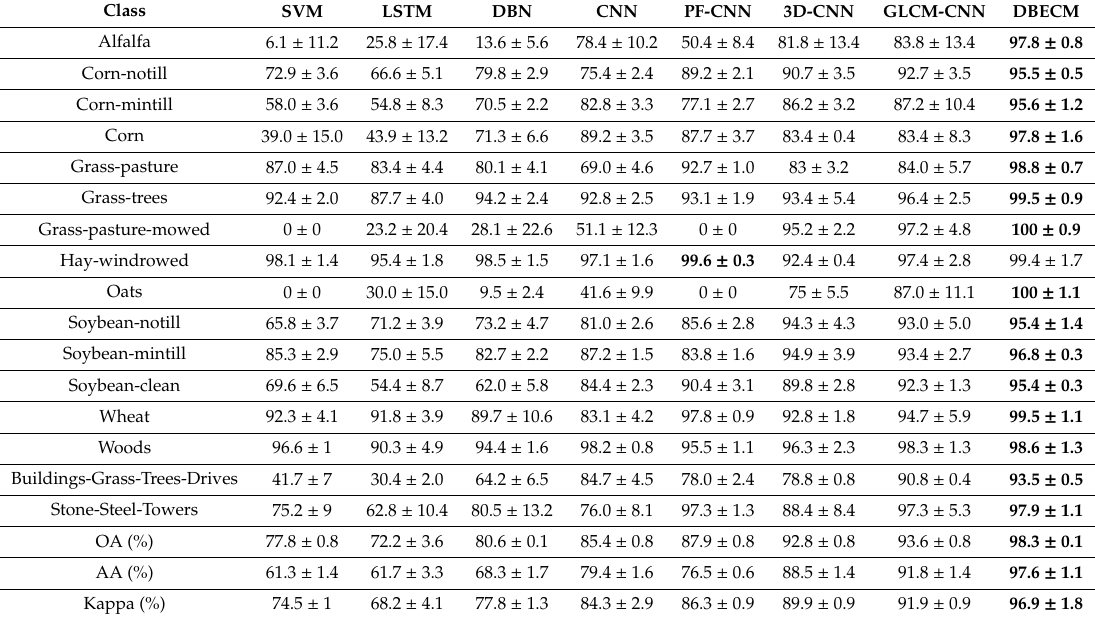
Table 2. Classification results of seven methods of the Indian pines dataset in the 10% train set. OA: CNN: convolutional neural network. DBECM: dual-branch extraction and classification